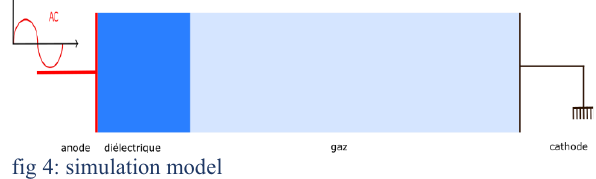
fig 4: simulation